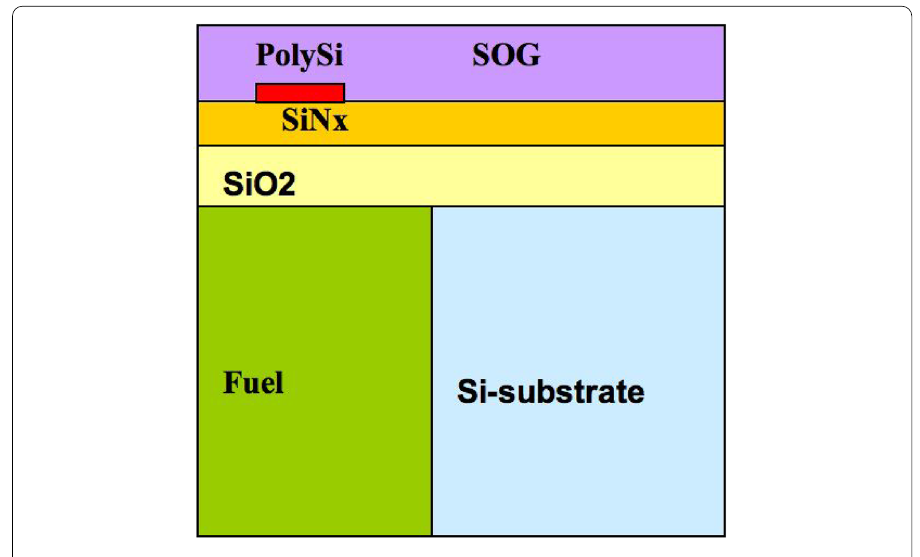
Fig. 1 A schematic 2D illustration of the microthruster